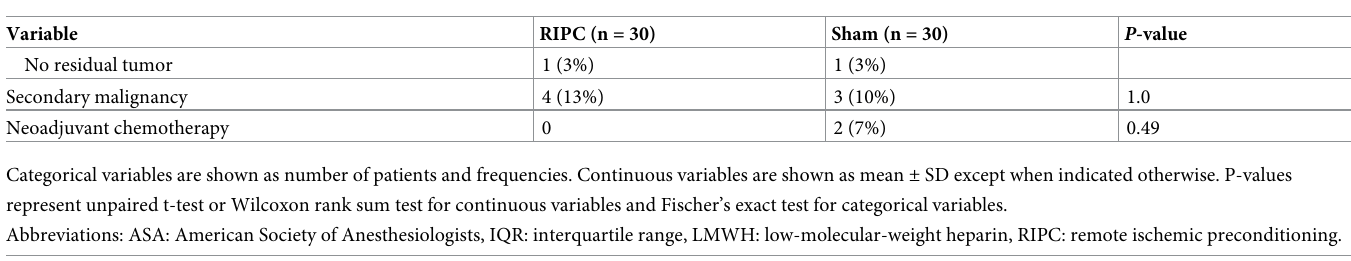
Abbreviations: ASA: American Society of Anesthesiologists, IQR: interquartile range, LMWH: low-molecular-weight heparin, RIPC: remote ischemic preconditioning.